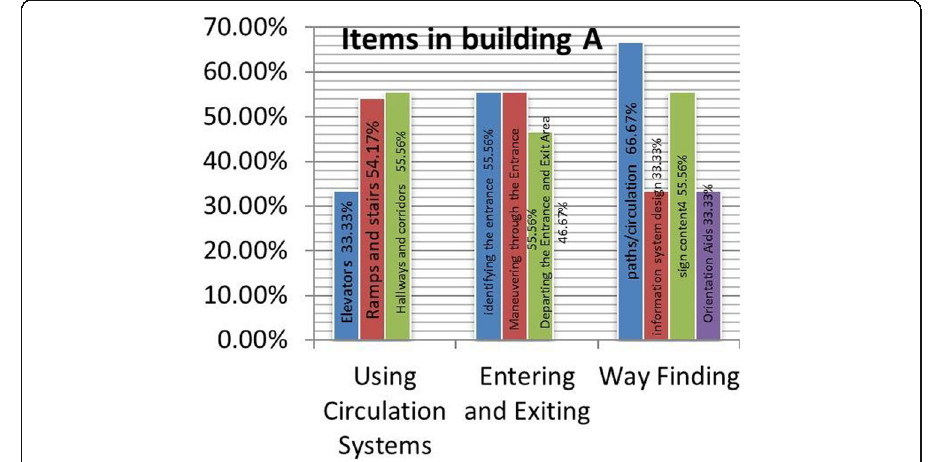
Fig. 20 Percentage of compliance to UD for the elements in building